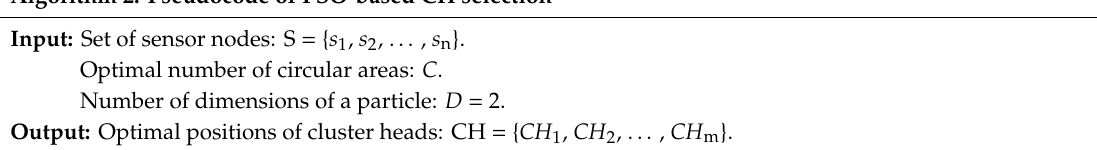
Algorithm 2: Pseudocode of PSO-based CH